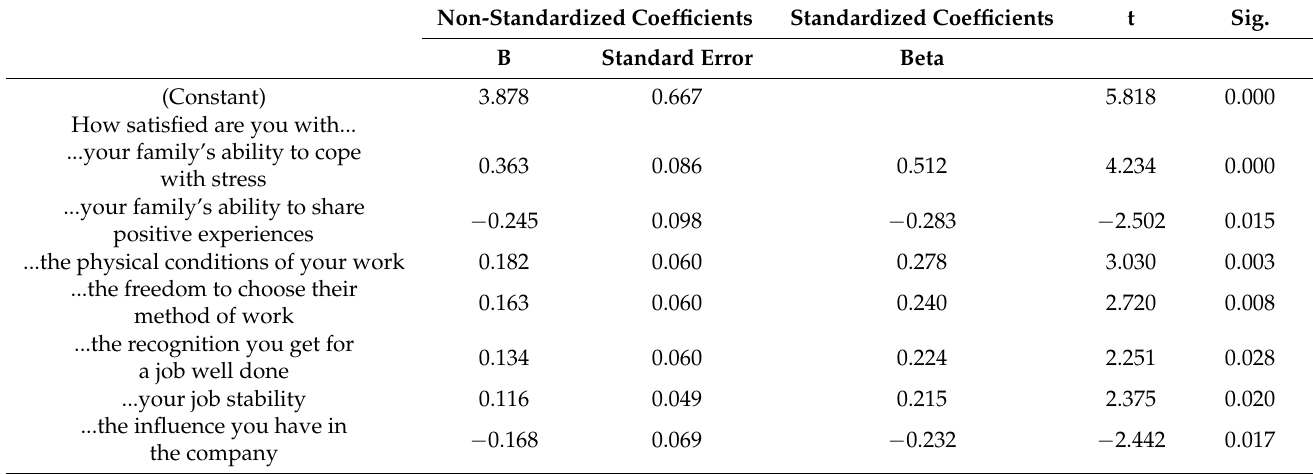
Table 9. Regression Coefficients Model 3 (Integrated